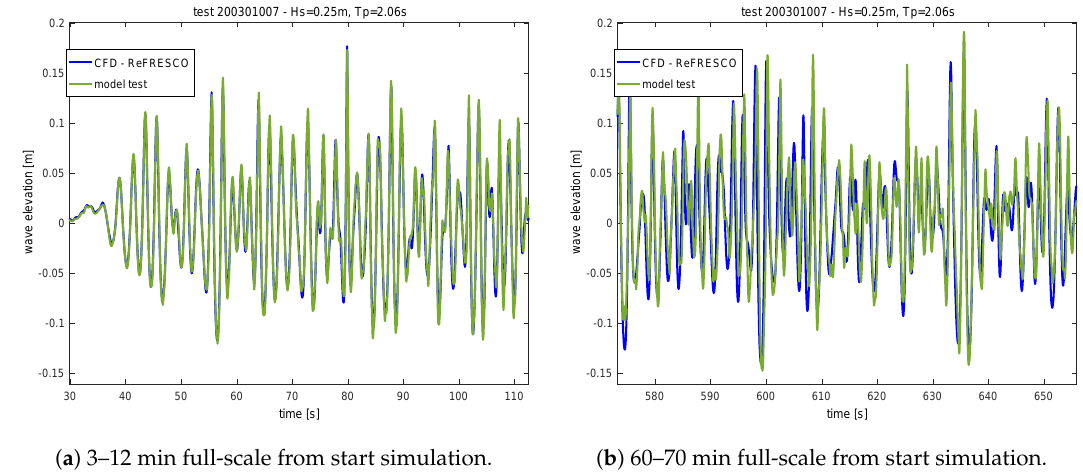
Figure 9. Measured (’model test’) and simulated (’CFD - ReFRESCO’) wave elevation for two parts of the time trace. Figure based on the same data as a figure in